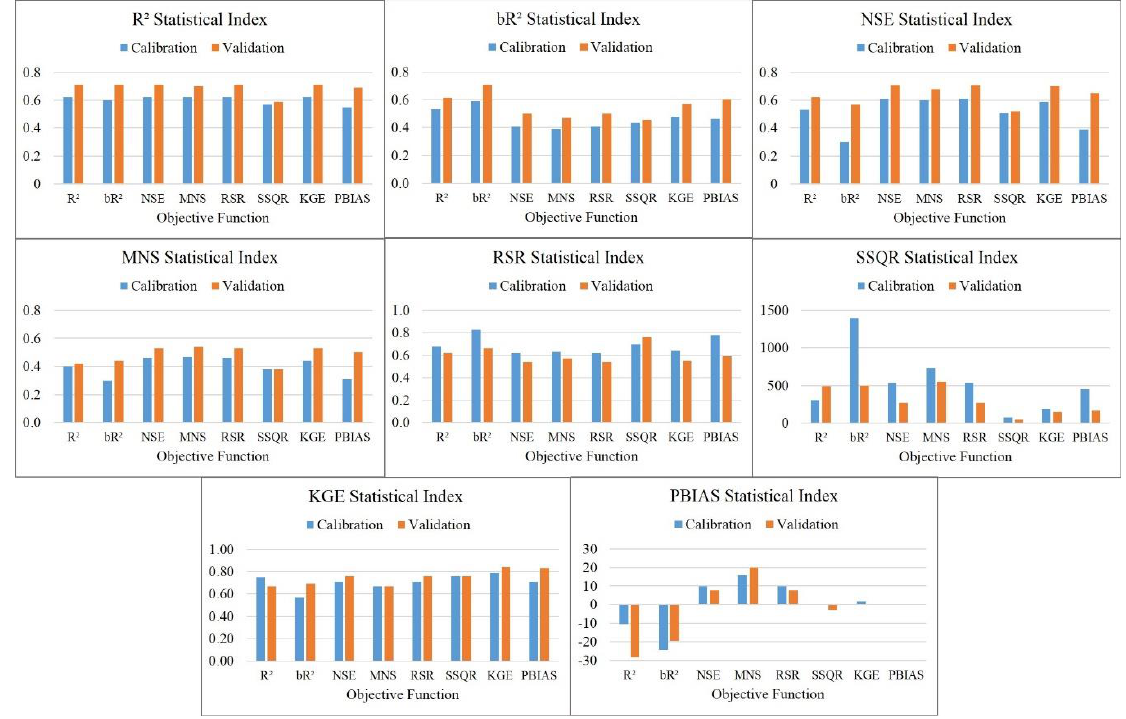
Figure 4. Results of model performance indices of different objective functions.